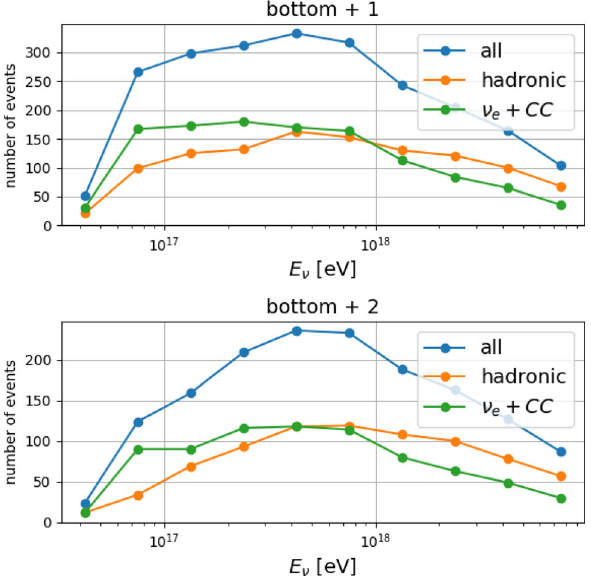
Fig. 16 Number of events contained in each of the energy bins in Fig. 15. Events are divided into the same categories as explained in Fig. 15